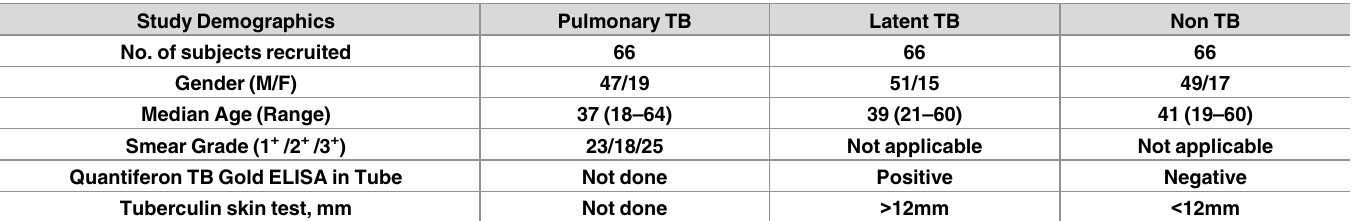
Table 1. Demographics of study